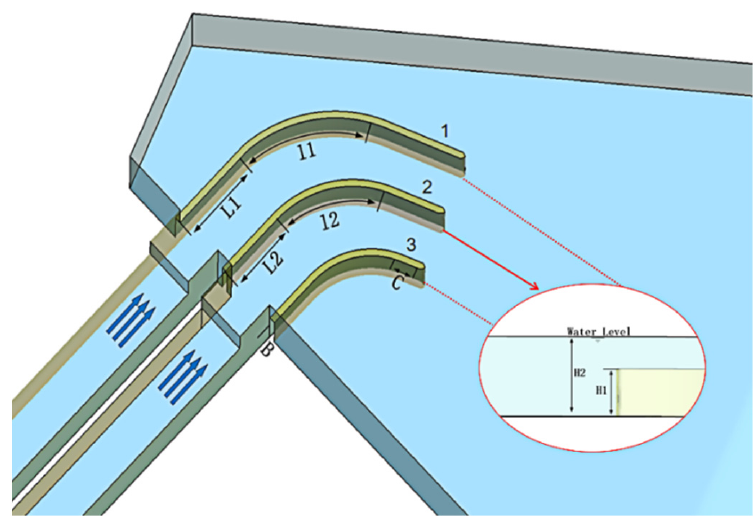
Figure 5. Dimension design of the diversion piers.